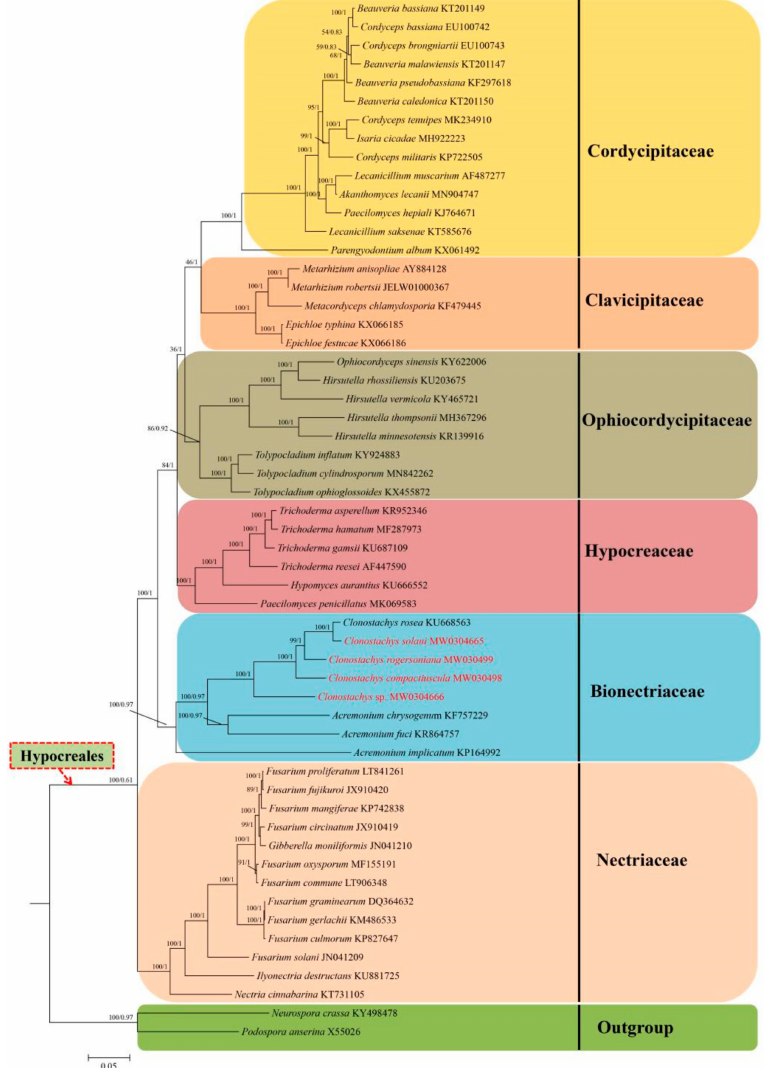
Figure 9. Molecular phylogenies of 54 species based on Bayesian inference and Maximum likelihood analysis of 14 protein-coding genes